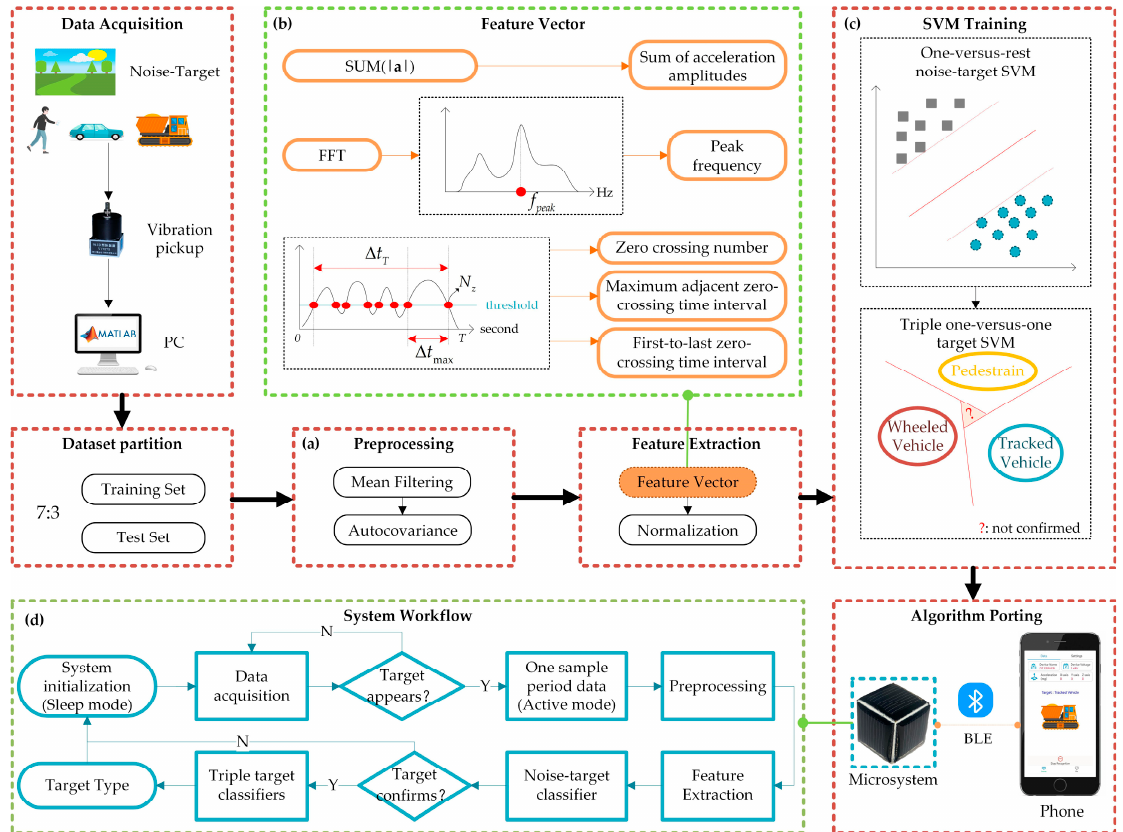
Figure 6. Recognition Algorithm and Software